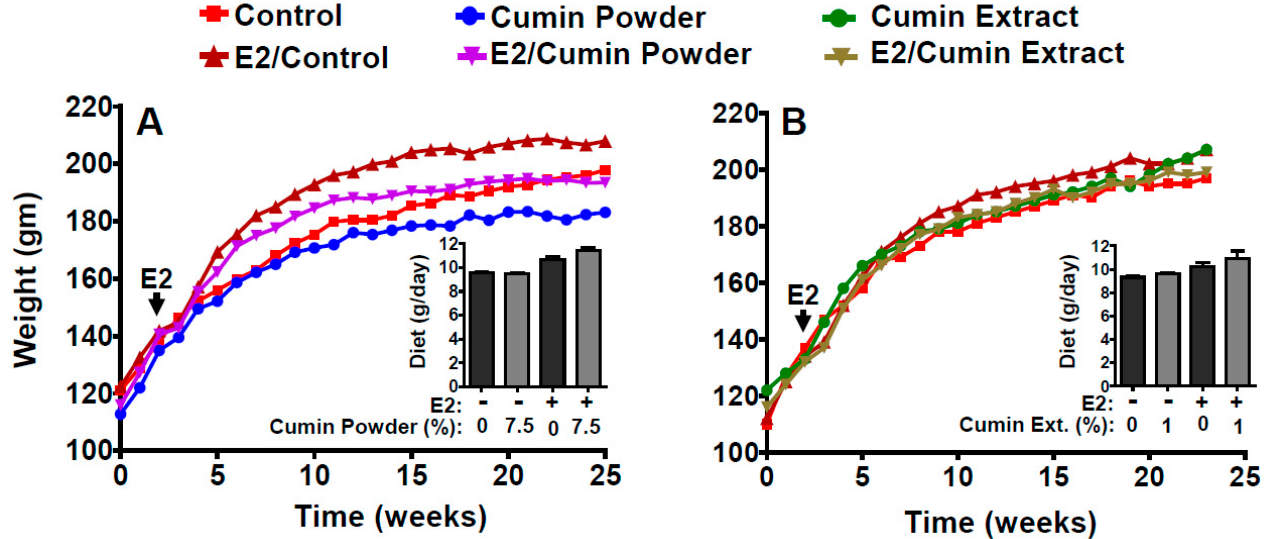
Figure 1. Effect of diet supplemented with cumin powder (7.5%, w / w ) ( A ) and dried ethanolic cumin extract (1%, w / w ) ( B ) on the body weight gain of the August Copenhagen Irish (ACI) rats. Inset in the left and right panels show the average daily diet consumption. Arrow in each figure shows the start of the 17ß-estradiol (E2) treatment.